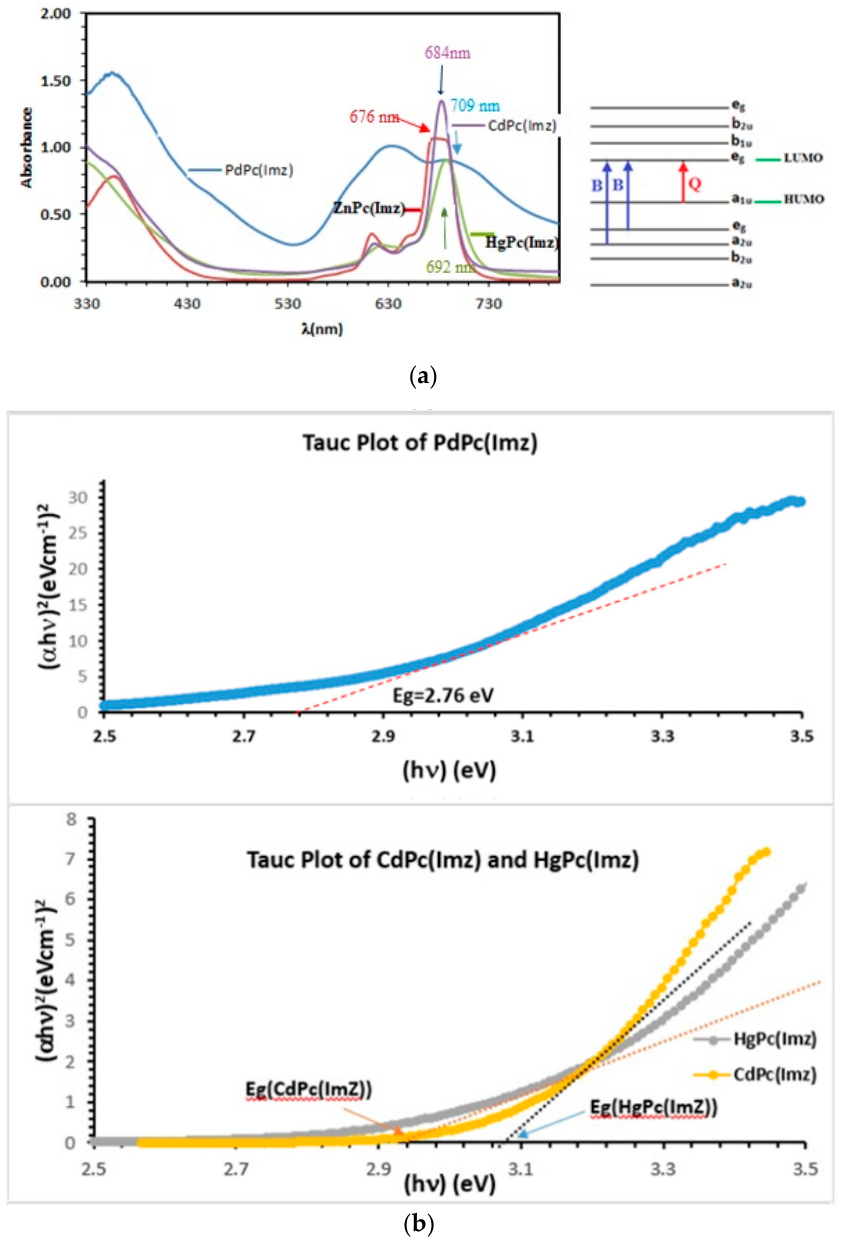
Figure 1. ( a ) UV-Vis spectra showing two characteristic bands of phthalocyanine: B bands at 352, 361 and 380 nm respectively, and Q bands at 680, 683 and 690 nm respectively. ( b ) Band gap (Eg) determination, using Tauc plot extrapolation.